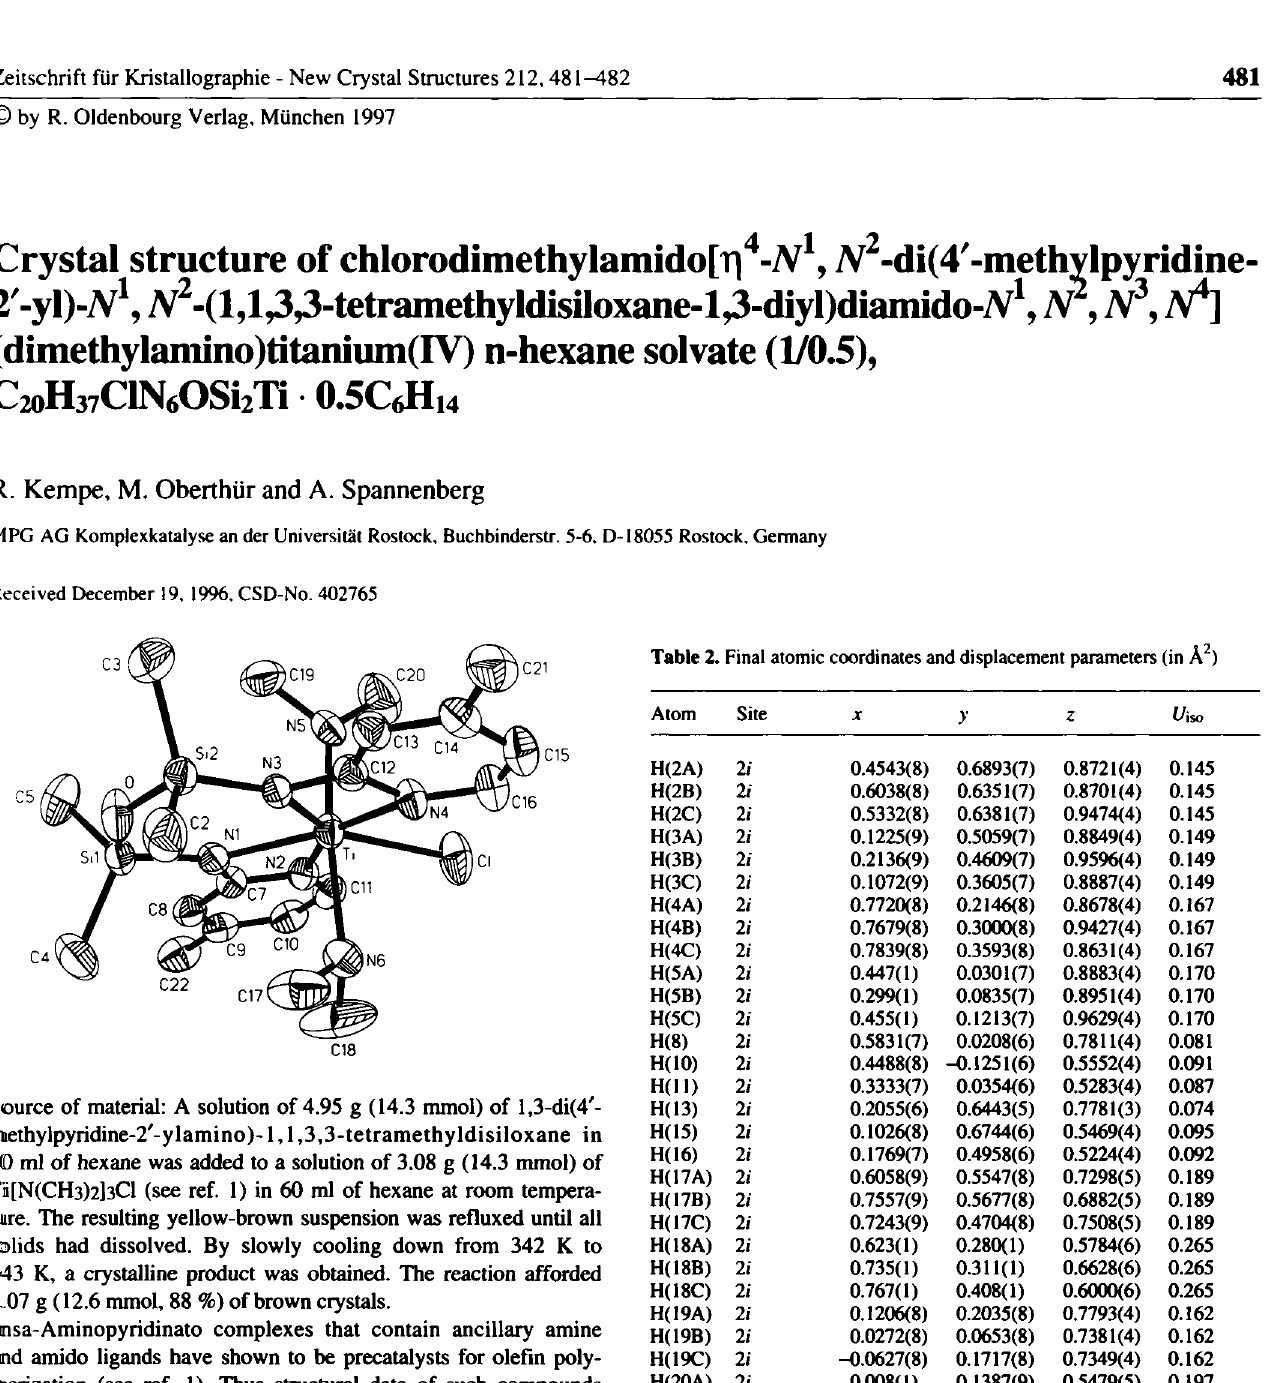
Table 1. Parameters used for the X-ray data collection Crystal: